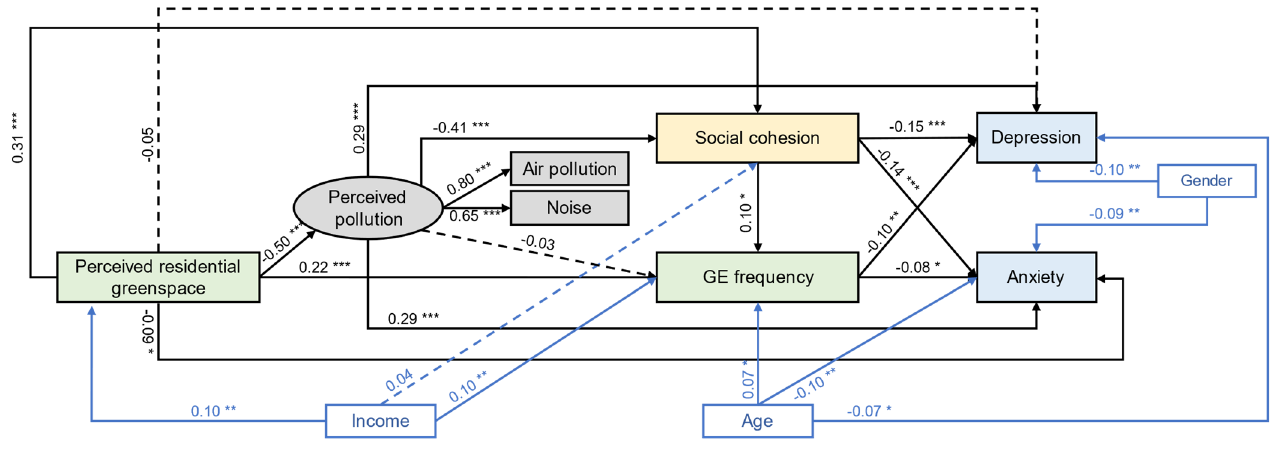
Figure 3. Final structural equation model (M2) with standardized regression weights ( β ) and signifi-